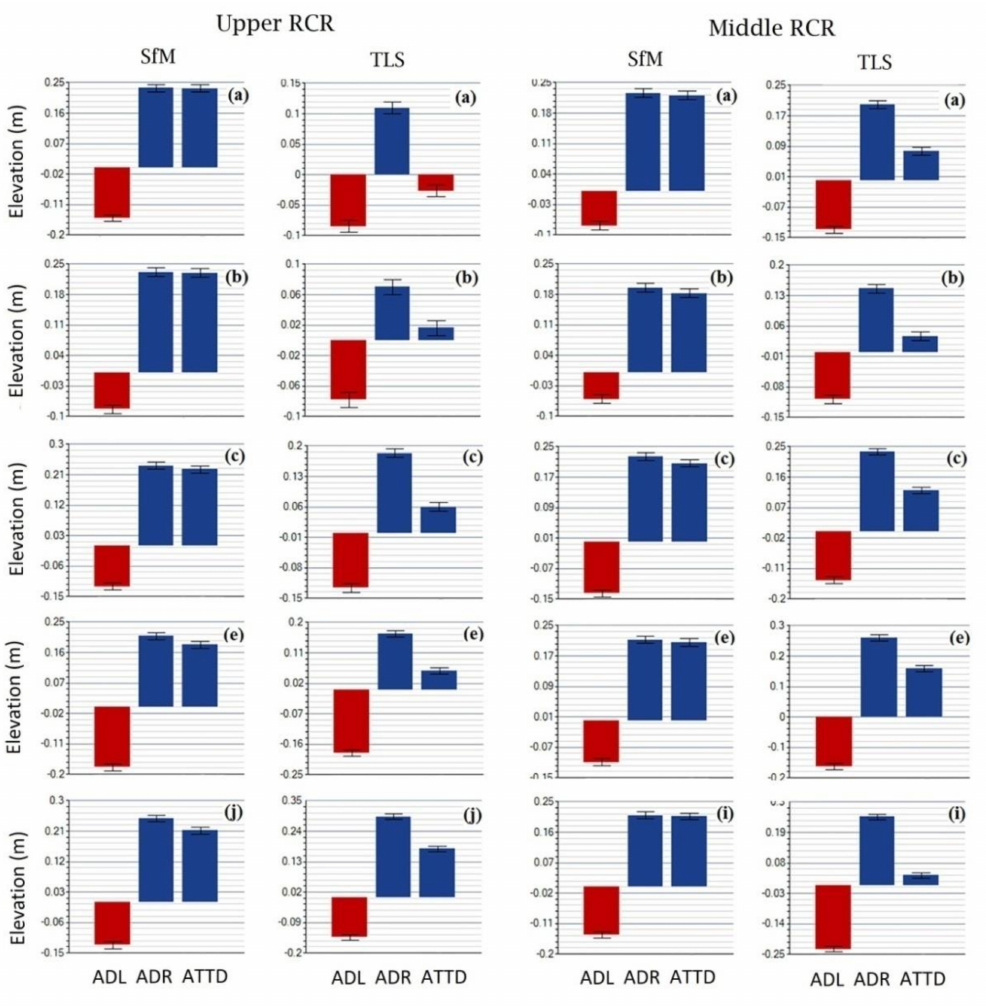
Figure 11. Average depth of lowering (ADL) and raising (ADR) and average total thickness di ff erence (ATTD) obtained from SfM-MVS and TLS for the GRUs in the Upper and Middle RCR, after the peak flow of 19–20 April 2019. Letters refer to the RGU according to the legend in Figure